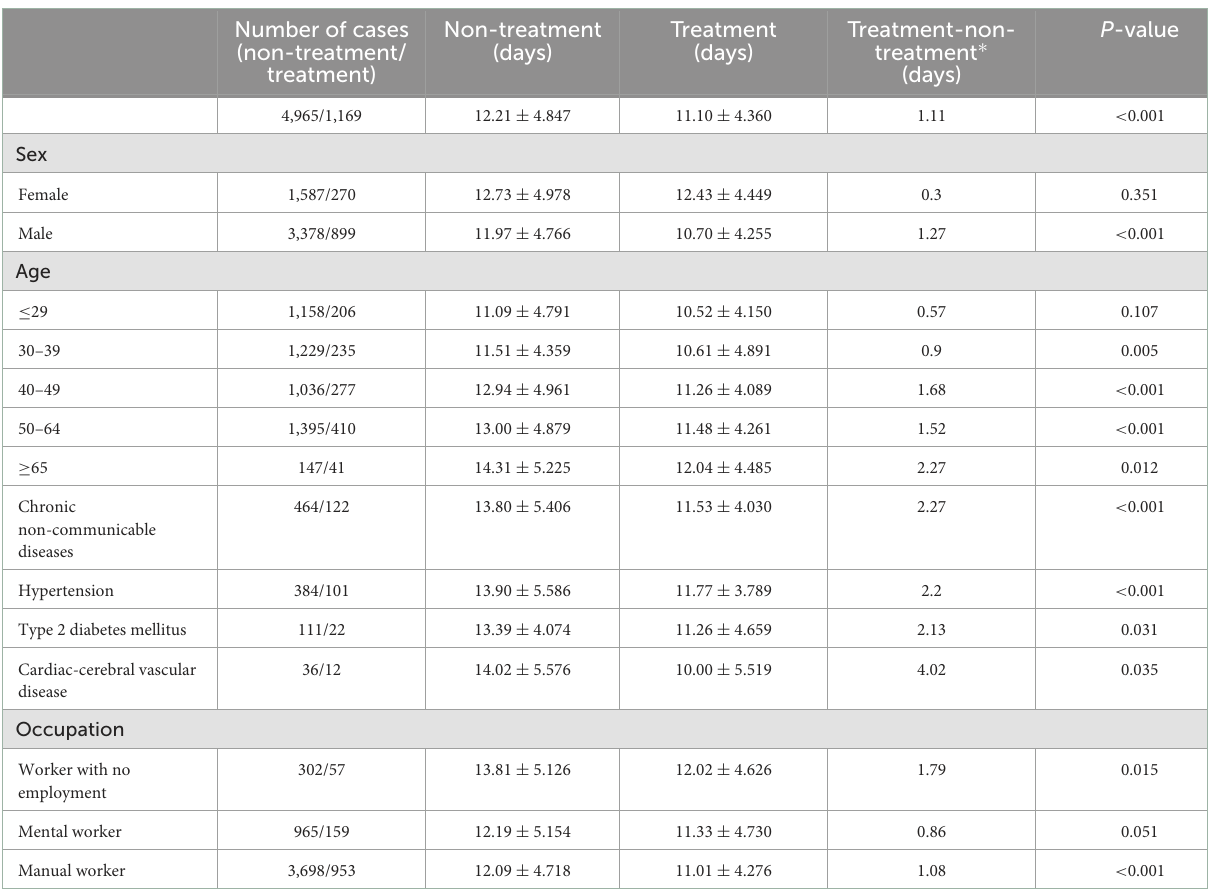
TABLE 4 Effect of treatment with TCM therapy on duration of viral